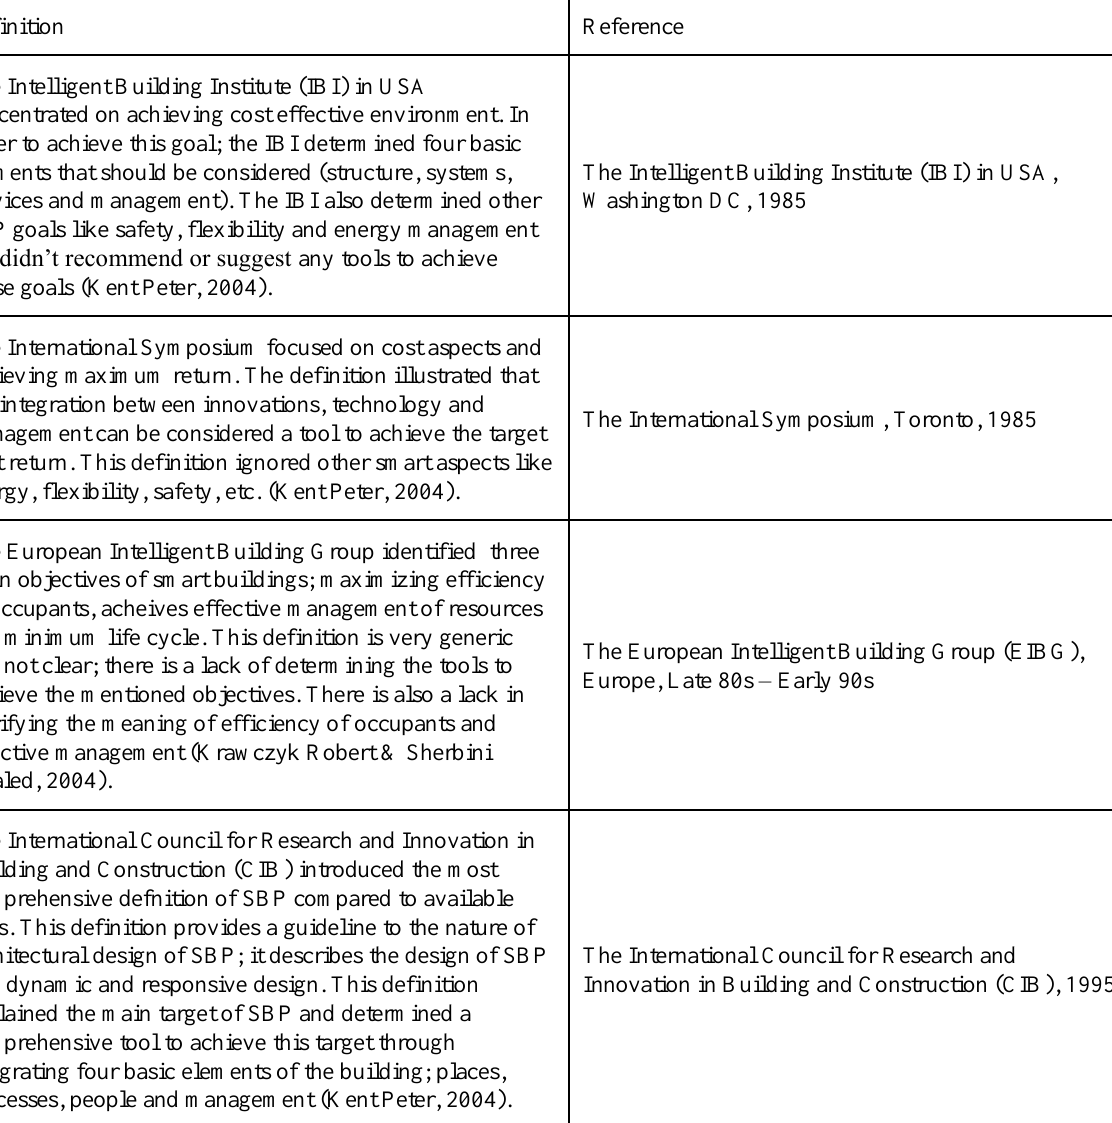
Table 1.Definitions of SBP; Source: Authors Based on Literature